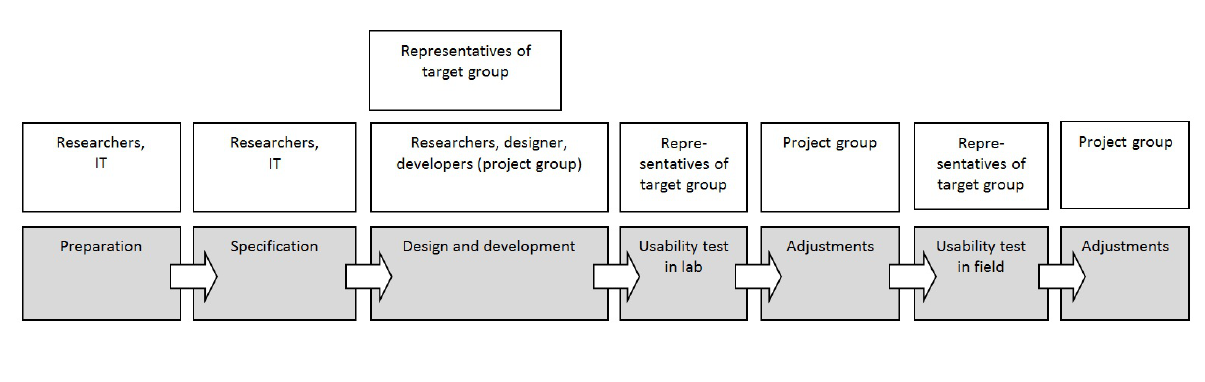
Figure 1. Development process of Young &